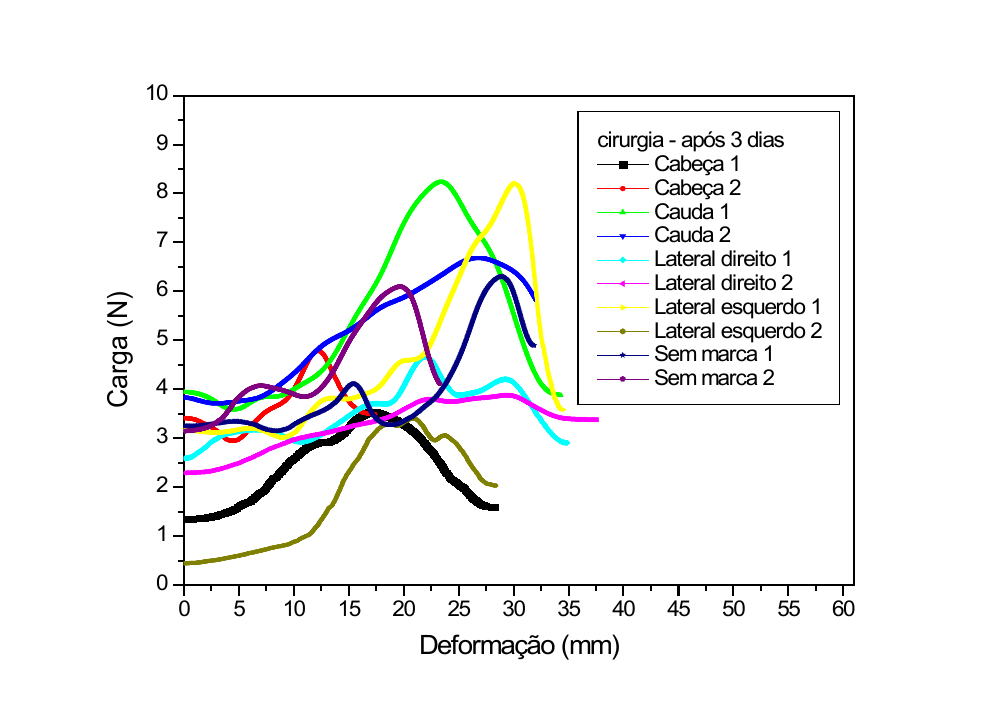
FIGURA 15 – Curva de carga versus deformação no grupo experimento três